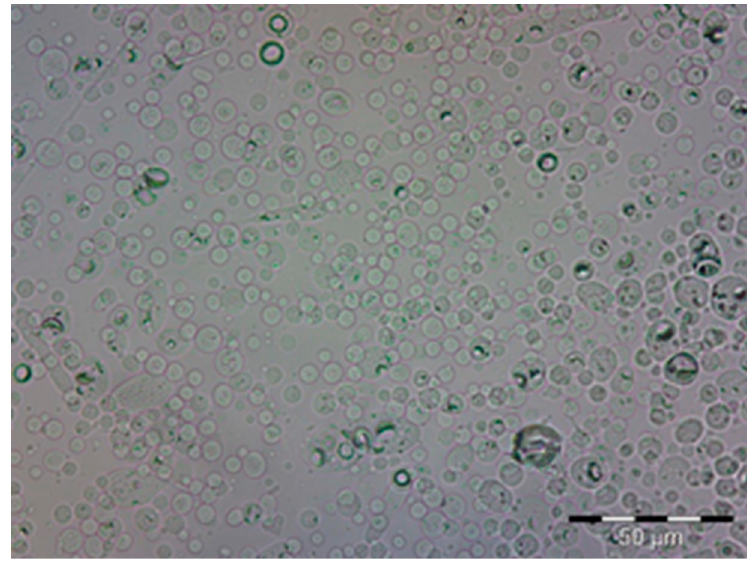
Figure 2. Optical microscopy image of microcapsules formed by complex coacervation (magnification 1000×).